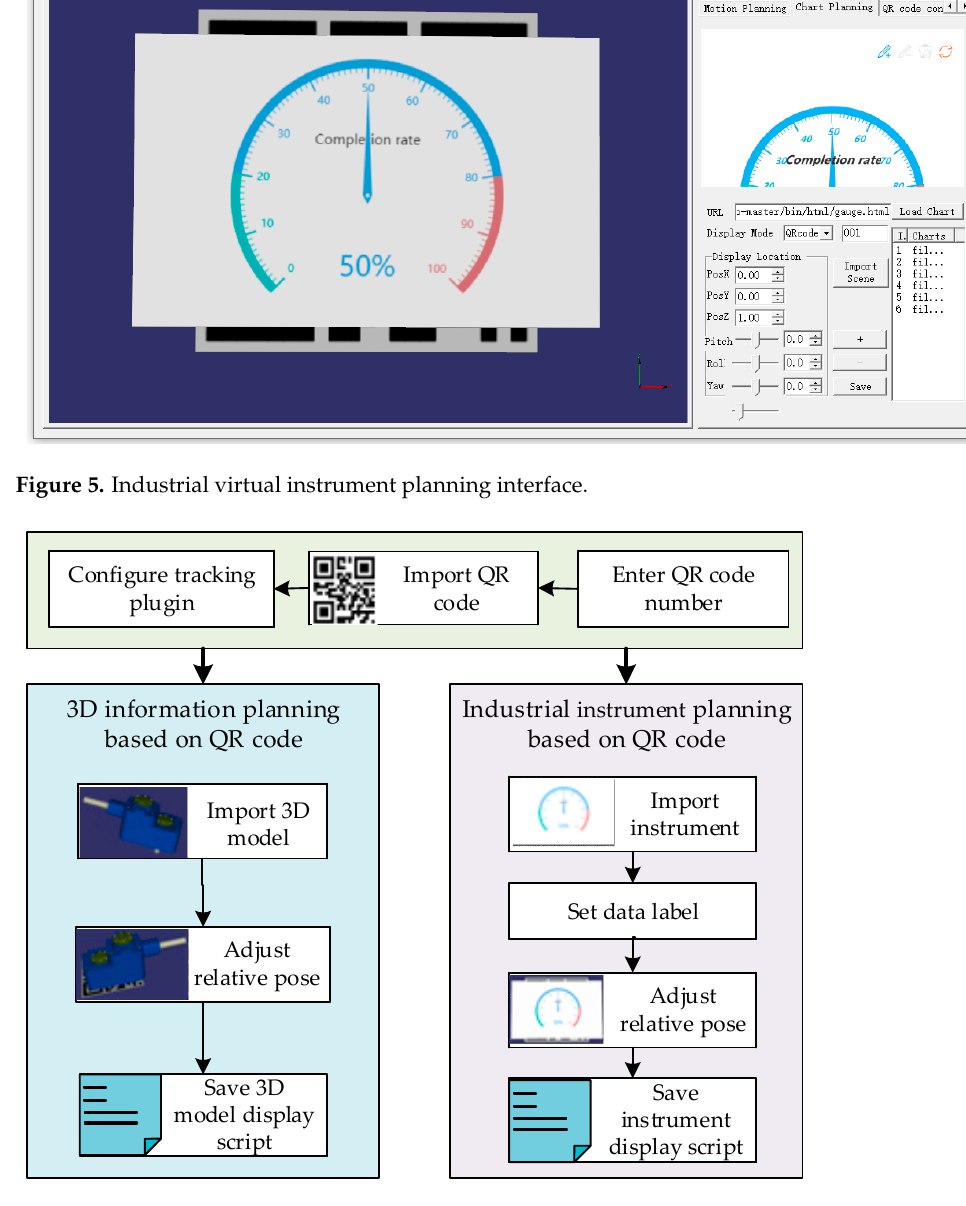
Figure 6. The flow chart of the QR code information configuration module.